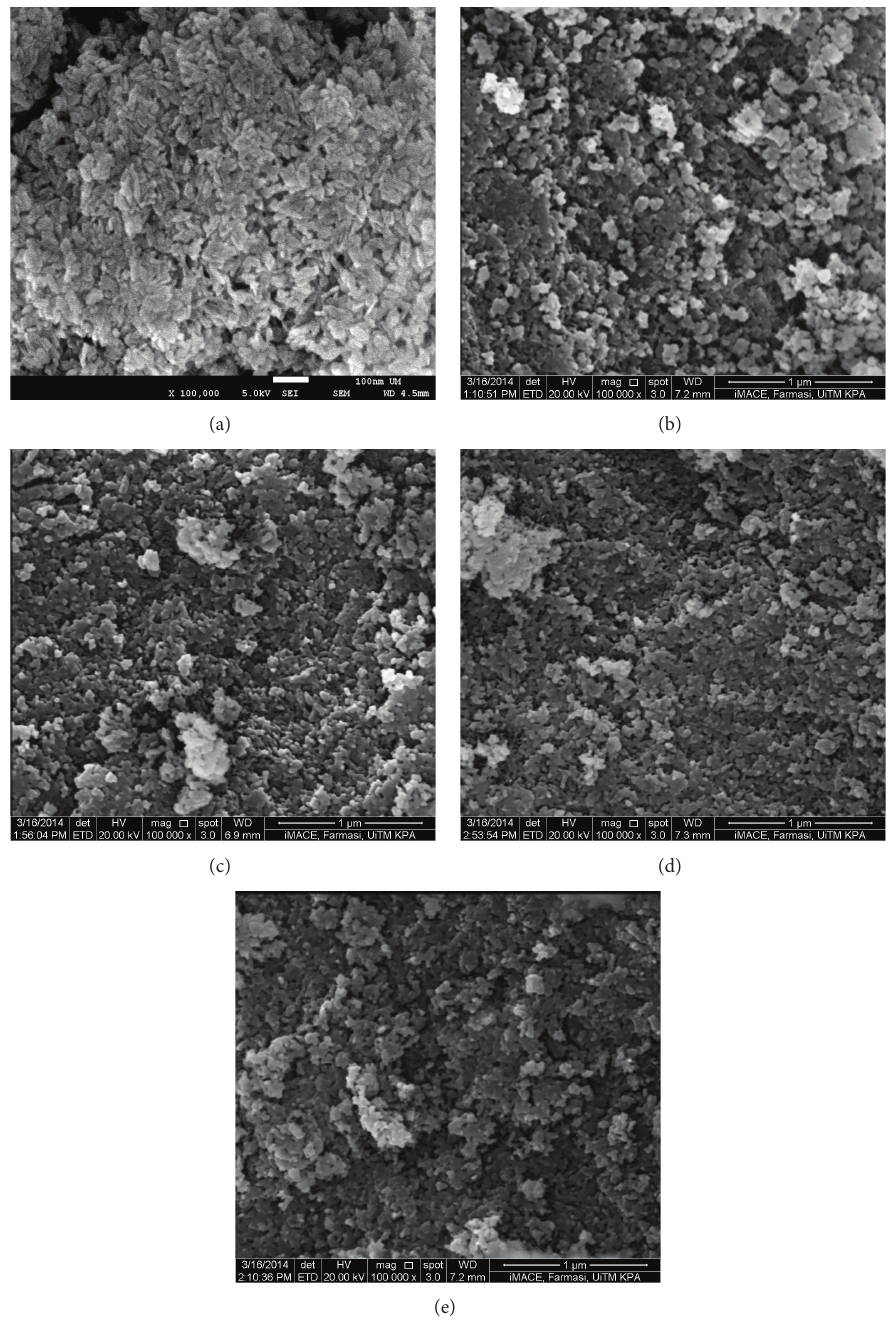
Figure 2: Scanning electron micrographs of (a) dHA-700, (b) cHA-900, (c) dHA-A900, (d) dHA-B900, and (e) dHA-C900 at magnification of 100